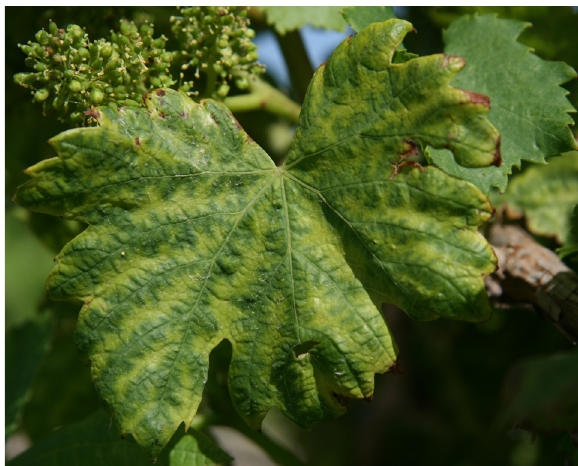
Fig. 2. Brown necrosis caused by L. theobromae exten- ding along a large part of the trunk: A, cross section; B, longitudinal section; C. black spots.